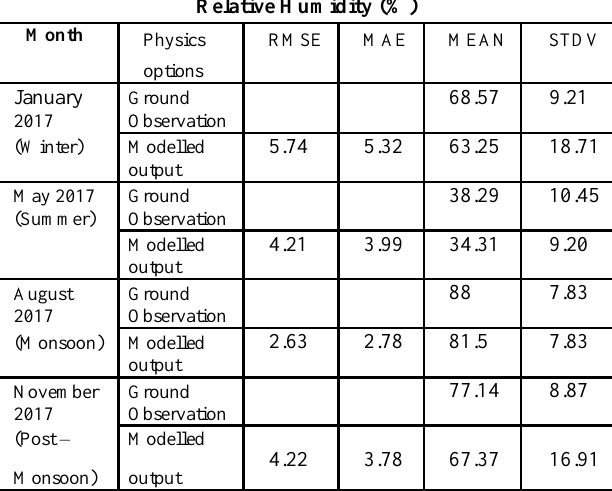
Table 5 Validation of the simulated results of Relative Humidity